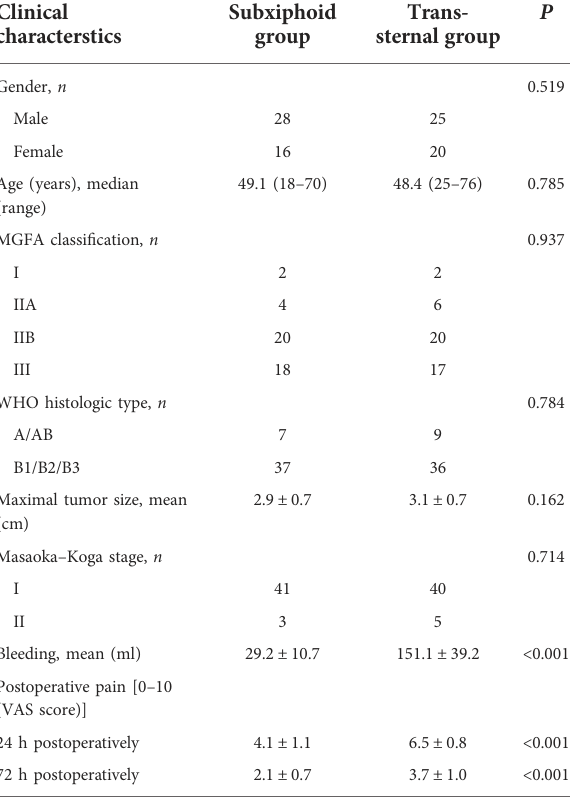
TABLE 1 Characteristics of clinical and pathological data between subxiphoid approach and trans-sternal approach groups.